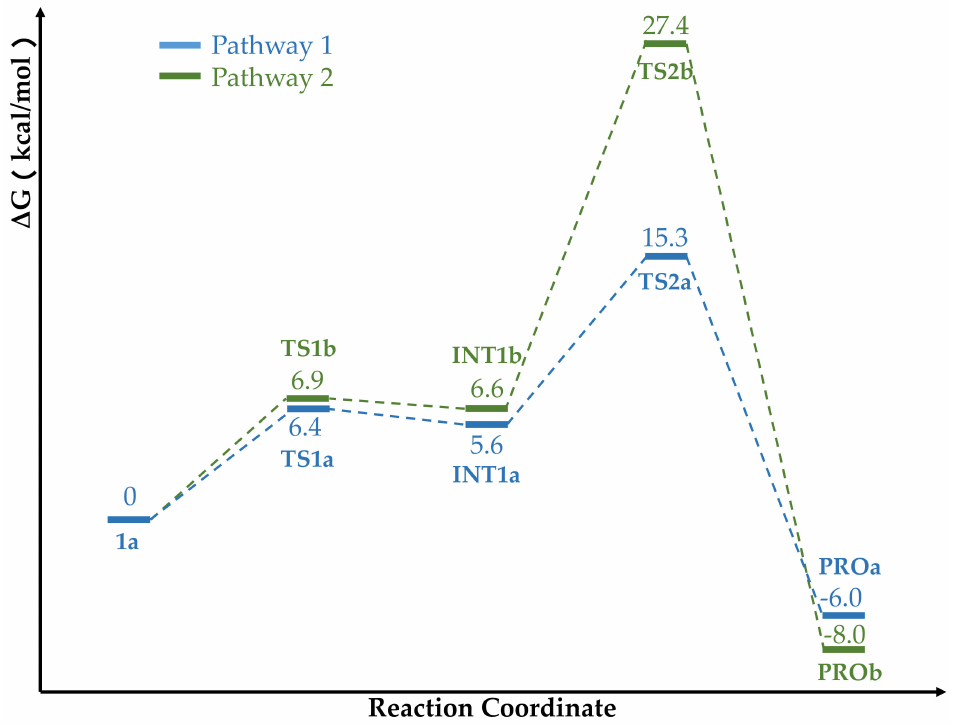
Figure 6. Free energy profile of the pathway 1 and pathway 2 . The relative energies are labeled in